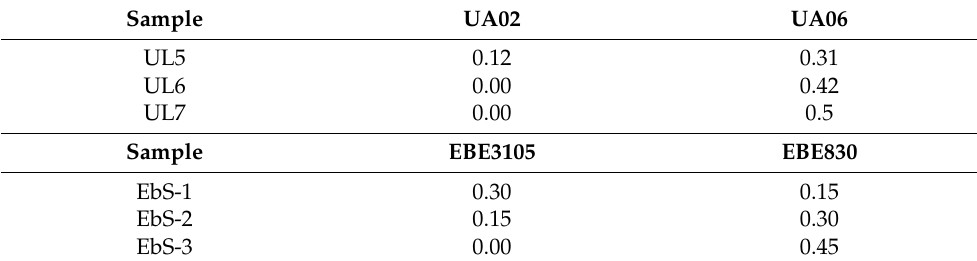
Table 1. Ion-exchange coating formulation